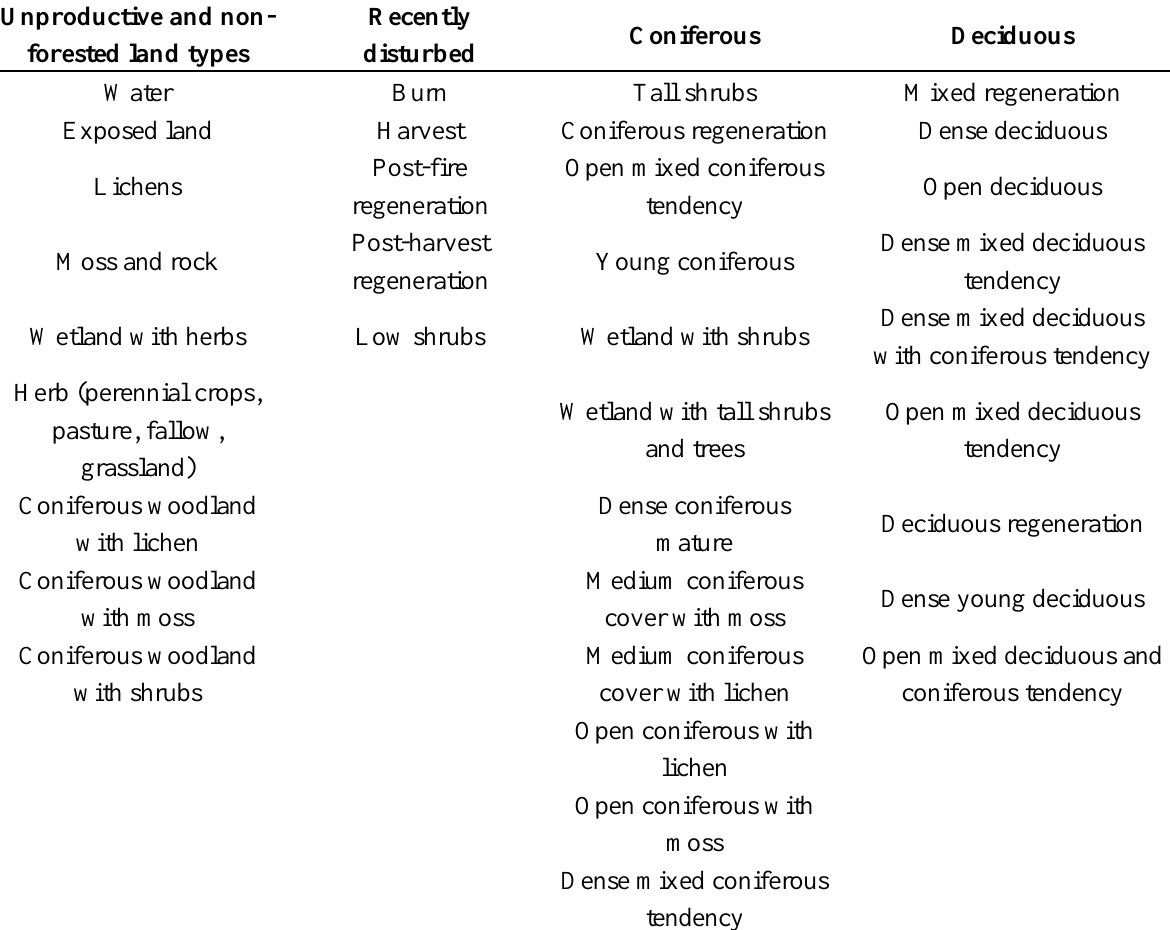
Table A4. Post-disturbance types of land cover composition